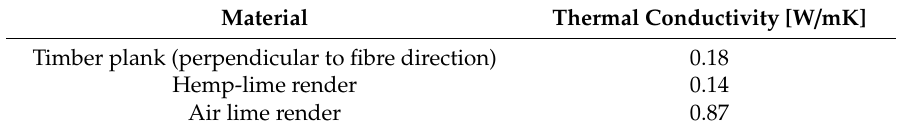
Table 4. Thermal conductivity of the materials used in the walls, measured with TPS1500, Hot Disk ® .